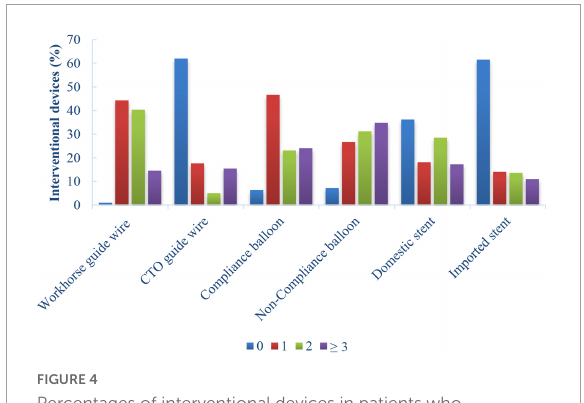
FIGURE4 Percentages of interventional devices in patients who underwent TRI using the GGEC I ( n = 221).